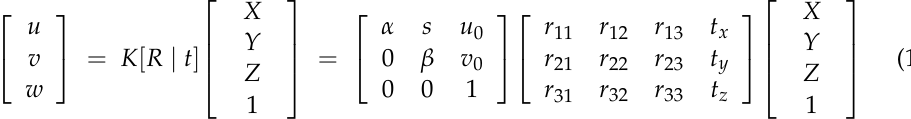
[ R | t ] . In Equation (16), u 0 and v 0 represent the pixels of the image plane center corre- sponding to the X - and Y -axes. Ideally, if the camera has a resolution of 800 × 600 pixels, u 0 is 400 pixels, and v 0 is 300 pixels. The α , β , and s are the calibration parameters in the intrinsic matrices of the camera, where α and β are the focal lengths of the camera in the X - and Y -axes, respectively. Finally, the s represents the distortion correction factor if the X - and Y -axes are not perpendicular to each other. By contrast, the extrinsic parameter matrix [ R | t ] is the transformation between the world coordinate system and the camera coordinate system, which is the transformation matrix M C that converts the base frame B into a camera